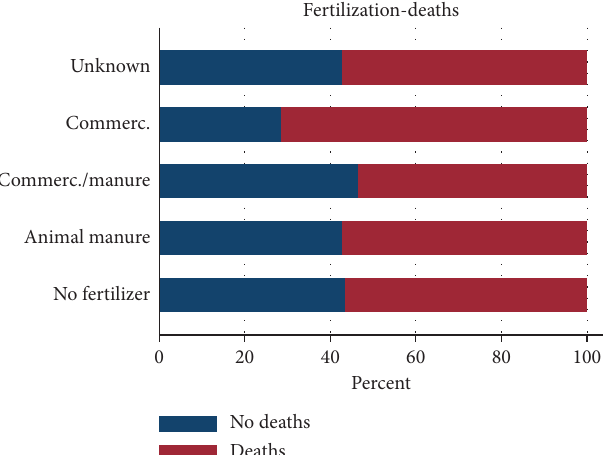
Figure 9: Deaths recorded for types of fertilization, all species and production systems combined. More deaths were recorded in farms using commercial